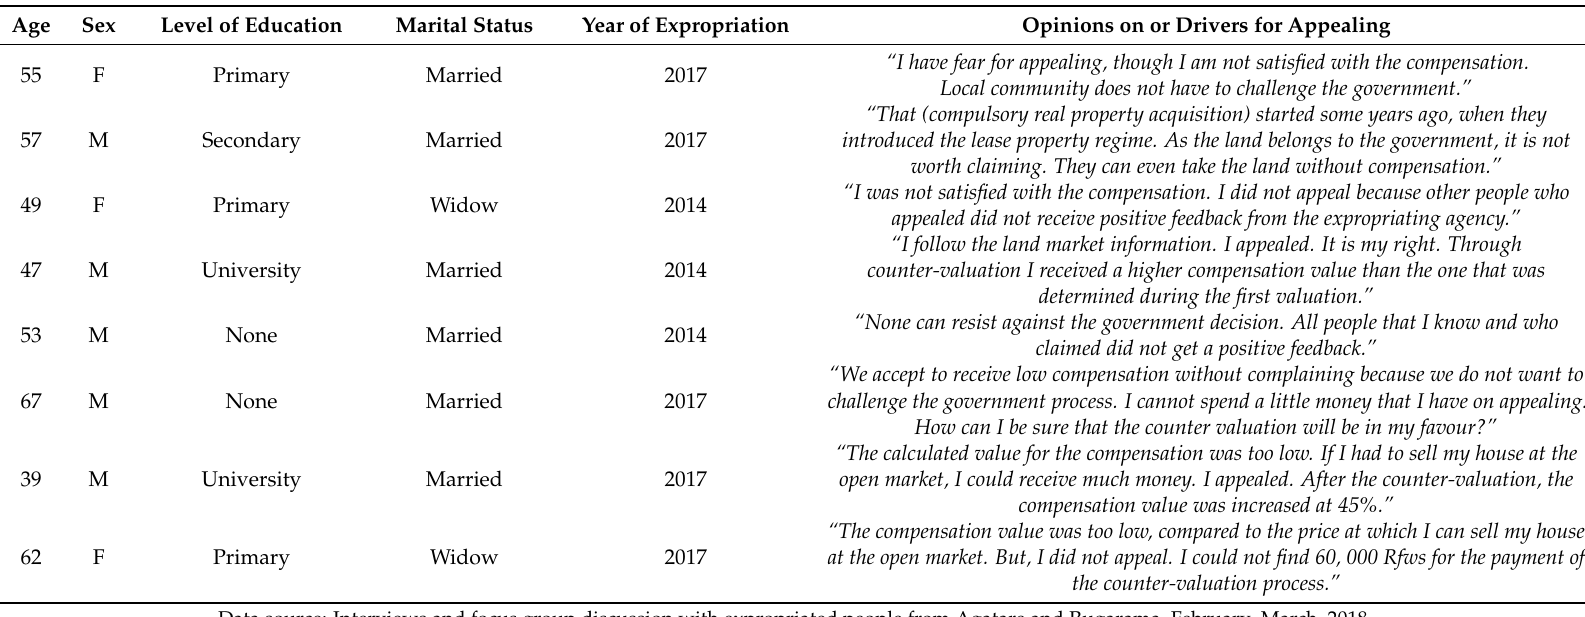
Table A5. Property owners’ decisions/perceptions on appealing and using counter-valuation